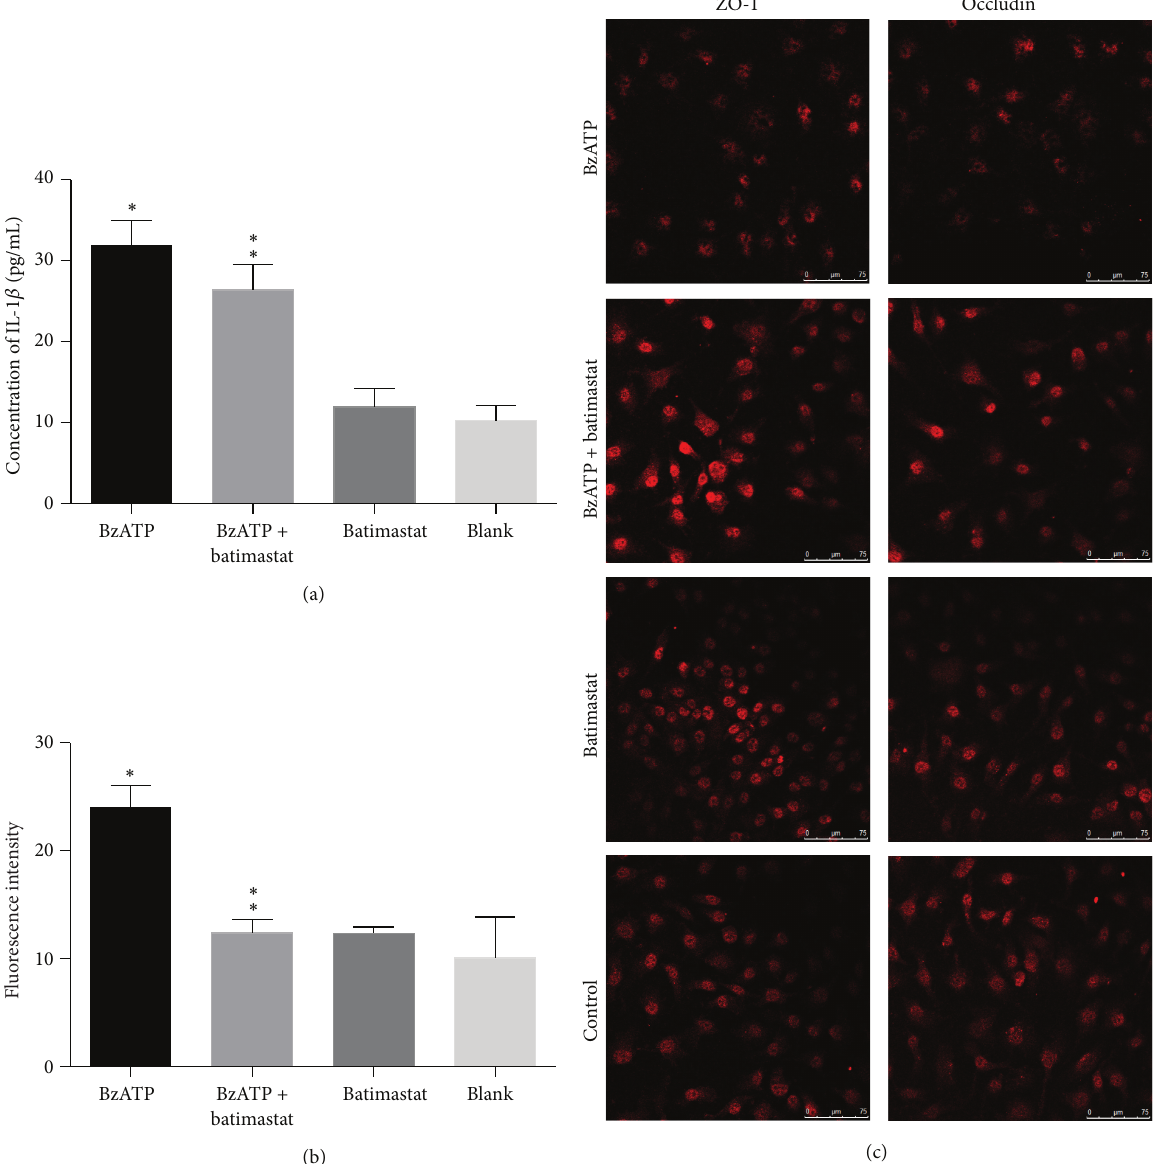
Figure 4: MMP-9-induced tight junction disruption and endothelial coculture system hyperpermeability were not attenuated by IL-1 𝛽 inhibition. (a) The levels of IL-1 𝛽 were significantly higher in BzATP groups than in control groups ( ∗ 𝑃 < 0.05 ). However, batimastat + BzATP treatment did not alter the level of IL-1 𝛽 versus BzATP group ( ∗∗ 𝑃 > 0.05 ). (b) Exposure to BzATP significantly increased the permeability to FITC-dextran compared with the control groups ( ∗ 𝑃 < 0.05 ). Batimastat attenuated BzATP-induced paracellular permeability versus BzATP group ( ∗∗ 𝑃 < 0.05 ). (c) Confocal microscopy images of immunofluorescence staining of ZO-1 and occludin demonstrating the